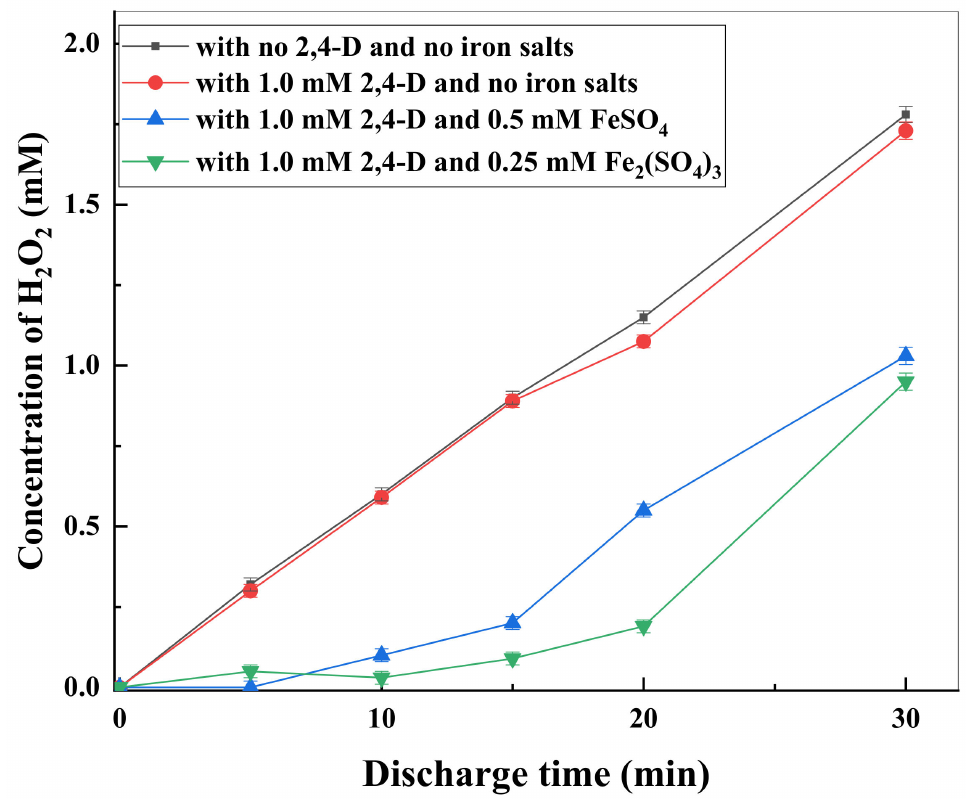
Figure 5. H 2 O 2 generation in the presence and absence of 2,4-D in RFD (input power, 200 W; [2,4-D] 0 , 1.0 mM; pH 0 ,